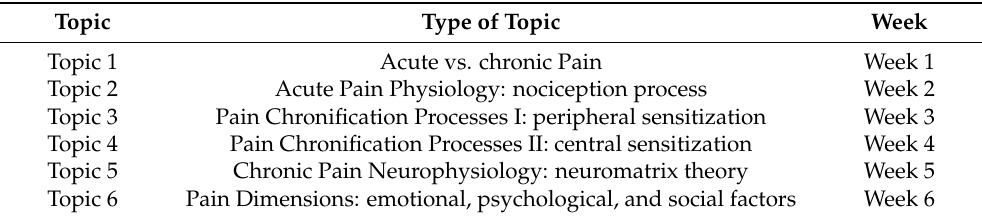
Table 1. Main topics of the Pain Neuroscience Education